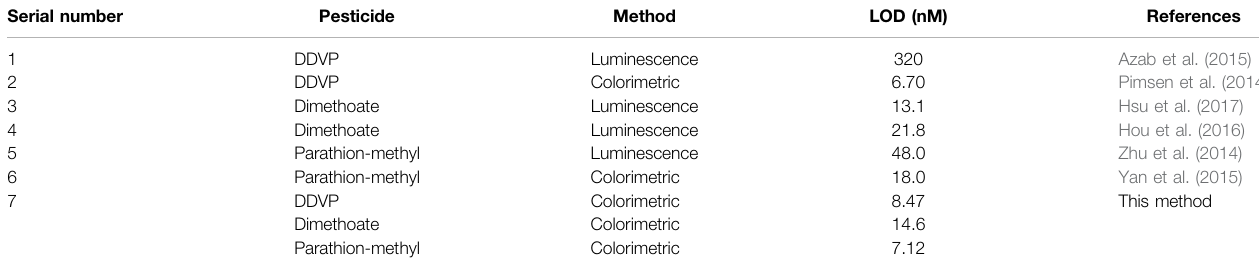
TABLE 4 | Comparison of our proposed method and the reported cases for pesticide analysis.